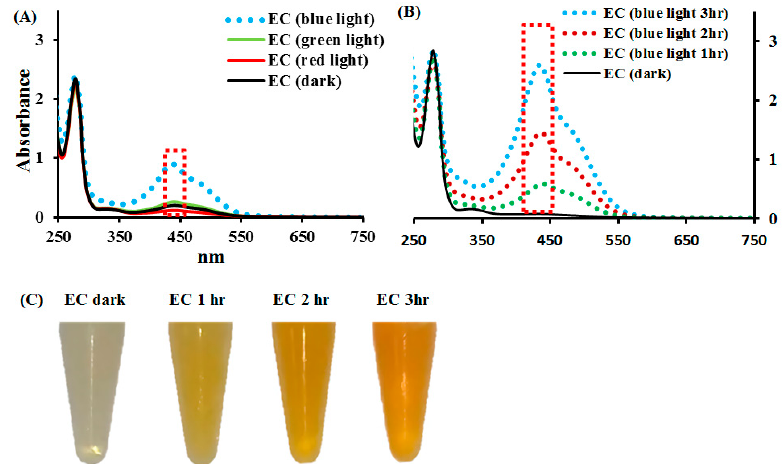
Figure 2. The absorption spectra of ( A ) 1 mM EC in 0.1 M phosphate buffer solution (ECPB) at pH 8, illuminated by blue, green, and red lights at 2.0 mW/cm 2 for 1 h, ( B ) ECPB treated with or without blue light illumination at 2.0 mW/cm 2 for 1, 2, and 3 h, and ( C ) the color changes in ECPB treated with or without blue light illumination at 2.0 mW/cm 2 for 1, 2, and 3 h. The absorbance of the reaction solutions was measured within the spectral range from 250 to 750